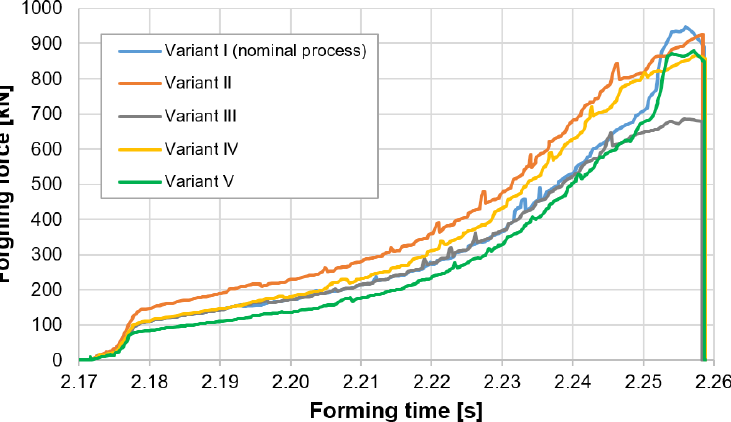
Figure 18. Courses of the extrusion forces in the function of deformation time.